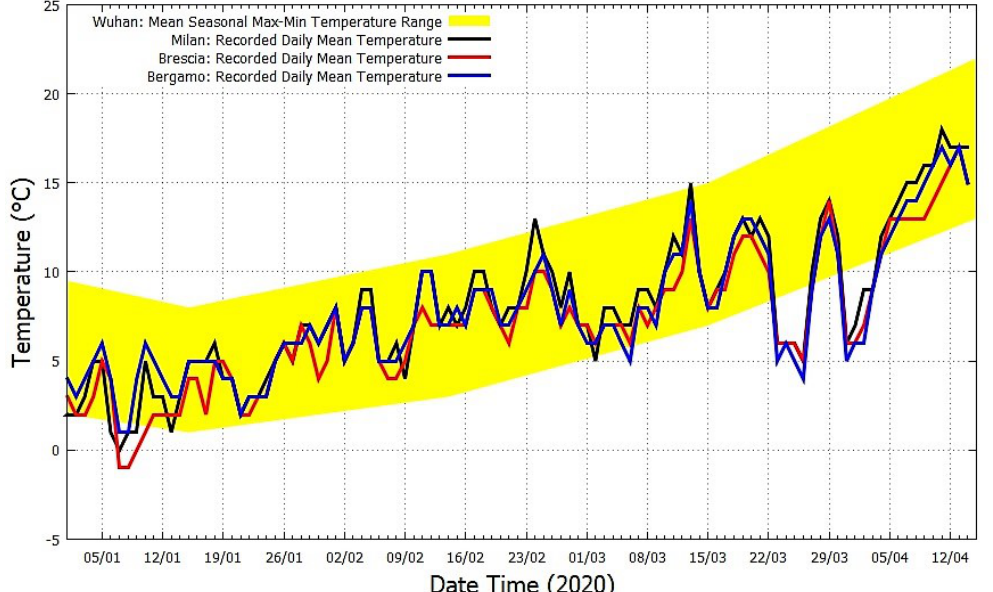
Figure 6. The daily mean temperature record of Milan, Brescia and Bergamo (black, blue and red) versus Wuhan’s climatic temperature averages